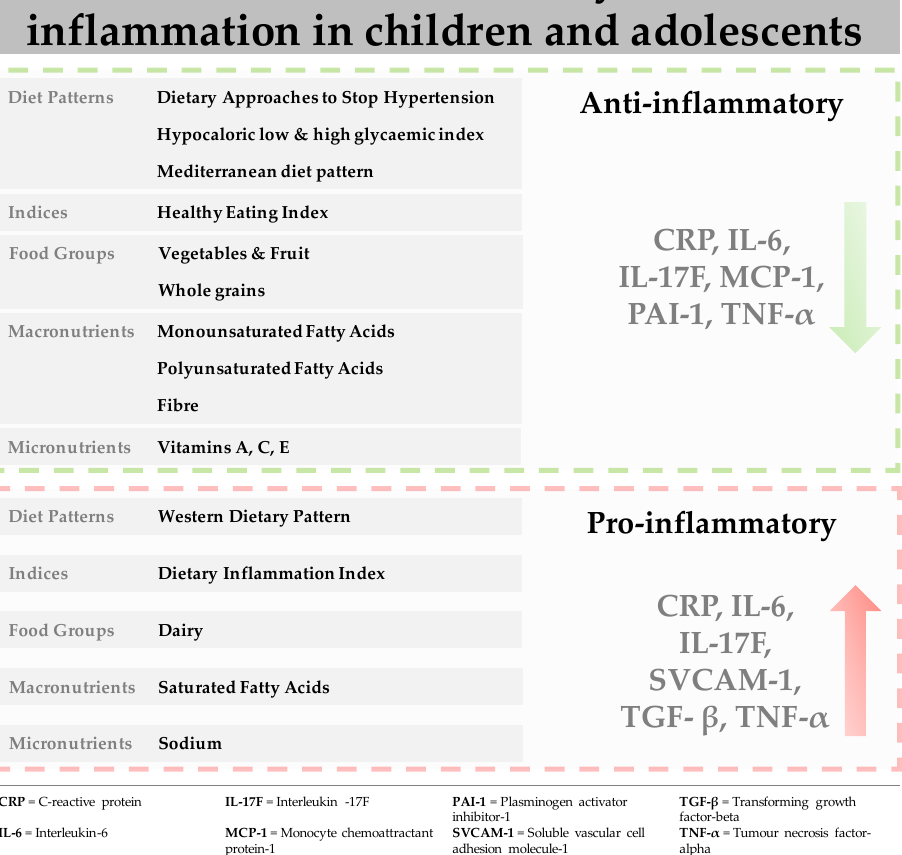
Figure 2. Association between dietary intake and biomarkers of inflammation in children and